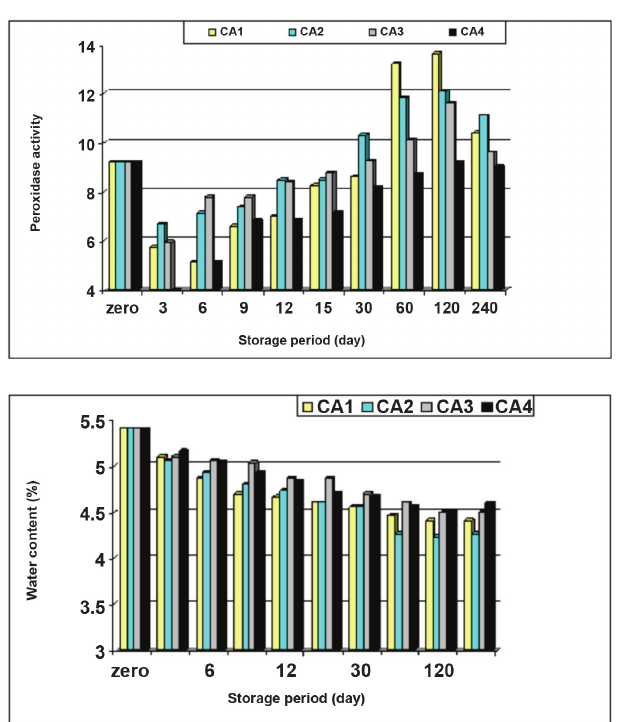
Fig. 4: Effect of the interaction between storage temperature (A, room temperature and B, cold temperature), controlled atmosphere and exposure period on catalase activity of onion seeds stored for 12 months. For more details about CA1 to CA4: 95.5 % N and 0.5 % O CA1: 4 % CO 2, 2 2 CA2: 8 % CO 91 % N and 1 % O 2, 2 2 CA3: 16 % CO 82 % N and 2 % O 2, 2 2 CA4: 24 % CO 73 % N and 3 % O 2, 2